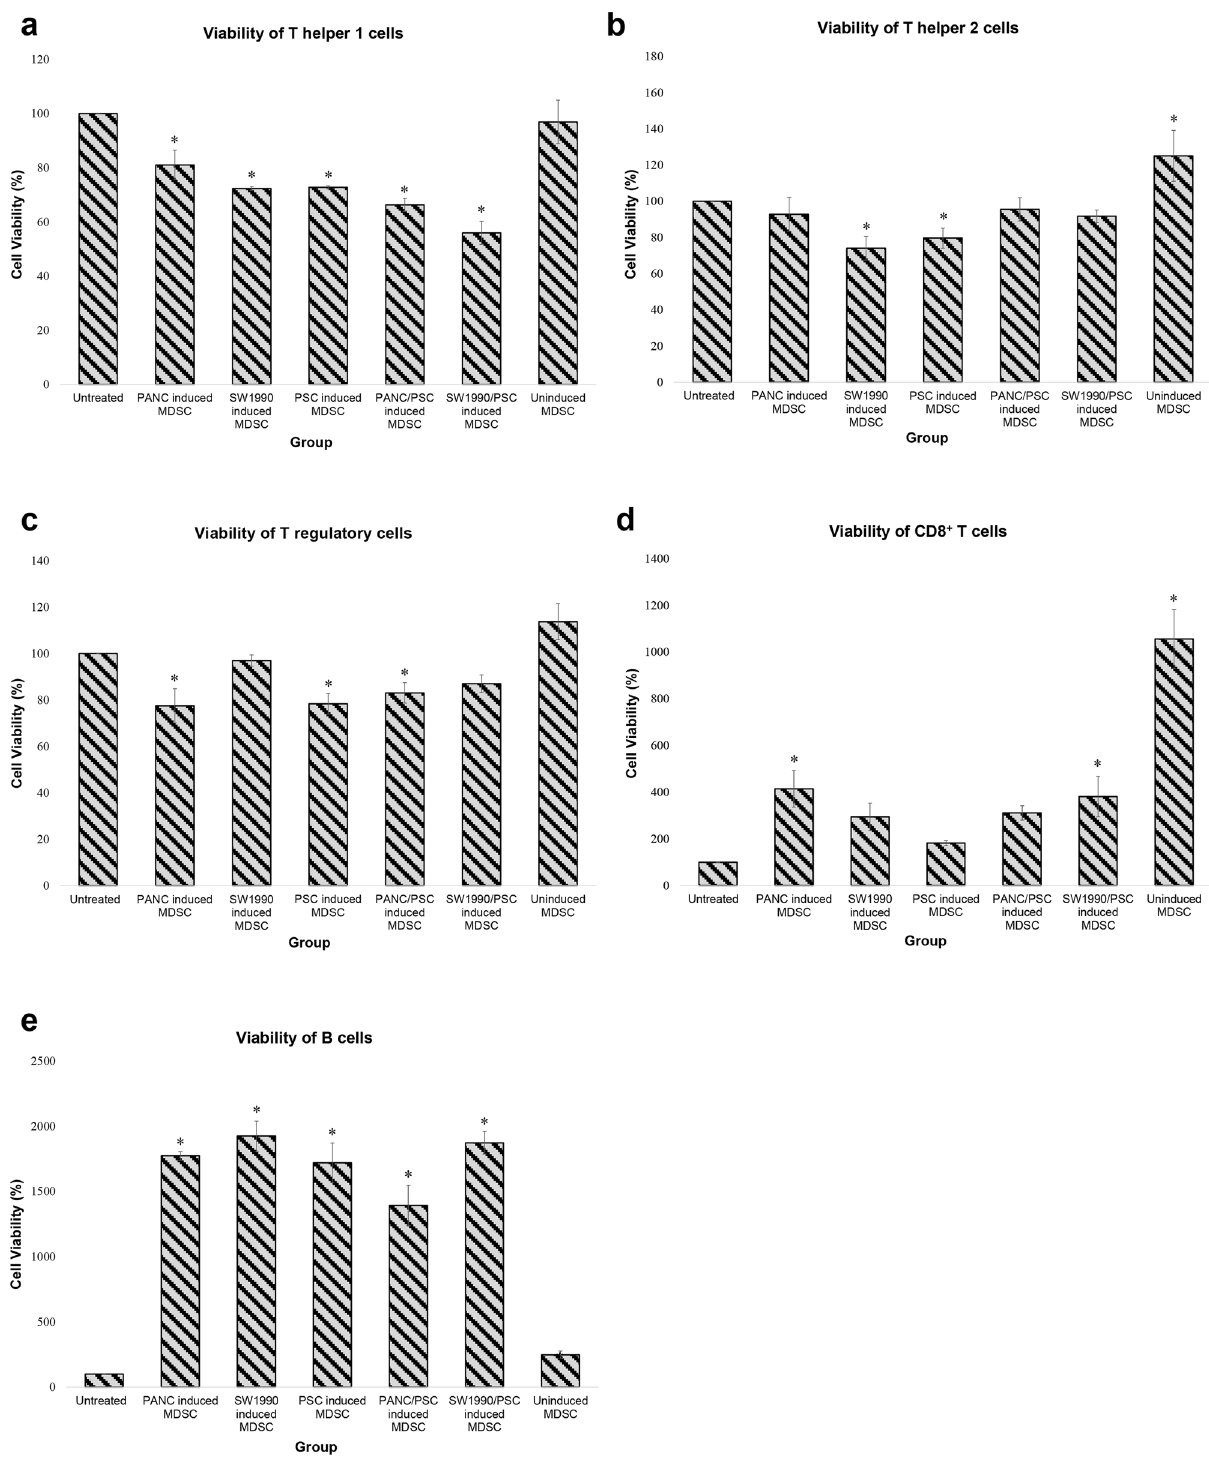
Figure 5. The viability of lymphocyte subtypes treated with MDSCs induced by PCCs and PSCs CM for 48 h. ( a ) Th1, ( b ) Th2, ( c ) Treg, ( d ) CD8 + T cells, and ( e ) B cells. Statistical significance is indicated by the asterisk above each column, in which the columns that have an asterisk represent that it has a significance of p ≤ 0.05 as compared to the untreated